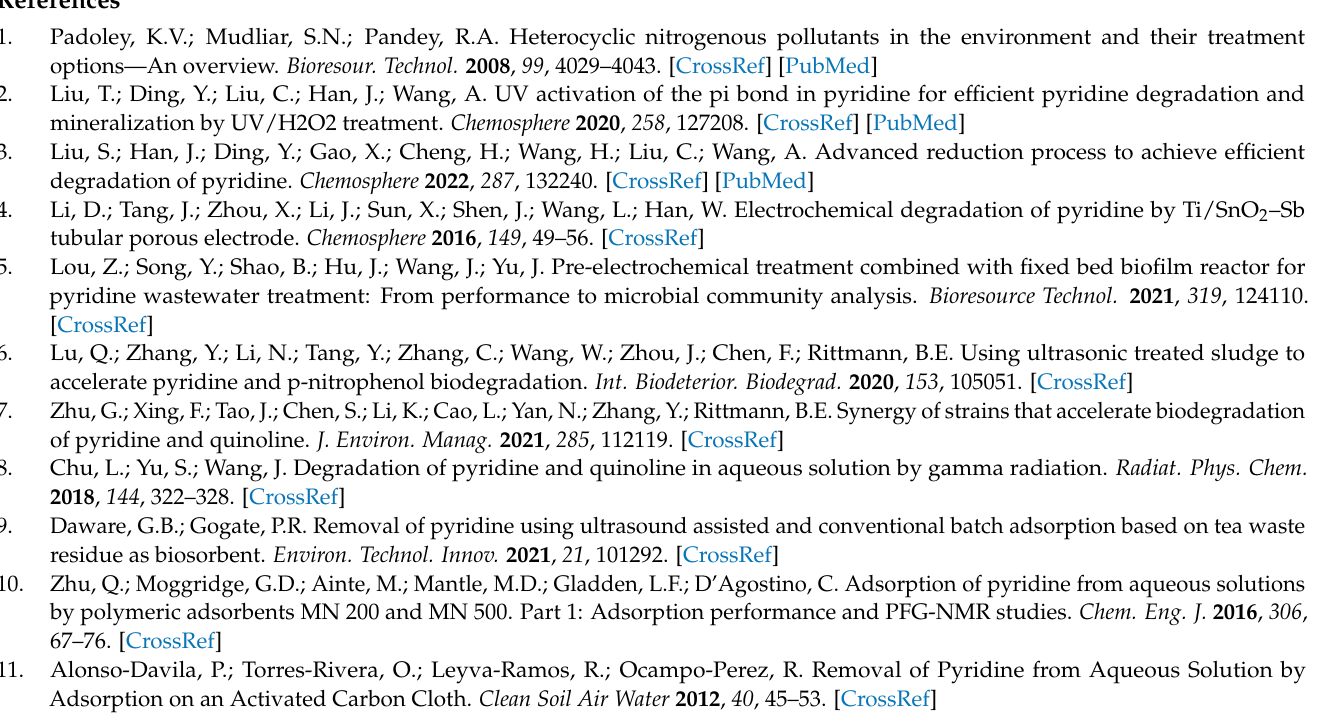
represented by dashed lines, while the discrete symbols correspond to experimental data; Figure S5: Variation in ACC adsorption capacity as a function of the mass of adsorbed pyridine at 200 RPM. The predictions of the Langmuir kinetic model are represented by dashed lines, while the discrete symbols correspond to experimental data; Figure S6: (a) Average velocity (cm/s) vs. time (s) as a function of the agitation rate. (b) Kinetic energy turbulence (cm 2 /s 2 ) vs. time (s) as function of the agitation rate. (c) Turbulence dissipation rate (cm 2 /s 3 ) vs. time (s) as a function of stirring speed; Figure S7: Variation in ACC adsorption capacity as a function of the mass of pyridine adsorbed. Here, the agitation rate is 100 rpm. Predictions from the advection–diffusion model are represented by dashed lines, while the discrete values correspond to experimental data; Figure S8: Variation in ACC adsorption capacity as a function of the mass of pyridine adsorbed. Here, the agitation rate is 200 rpm. Predictions from the advection–diffusion model are represented by dashed lines, while the discrete values correspond to experimental data; Figure S9: Comparison between the adjustment constants (a) ADM and (b)